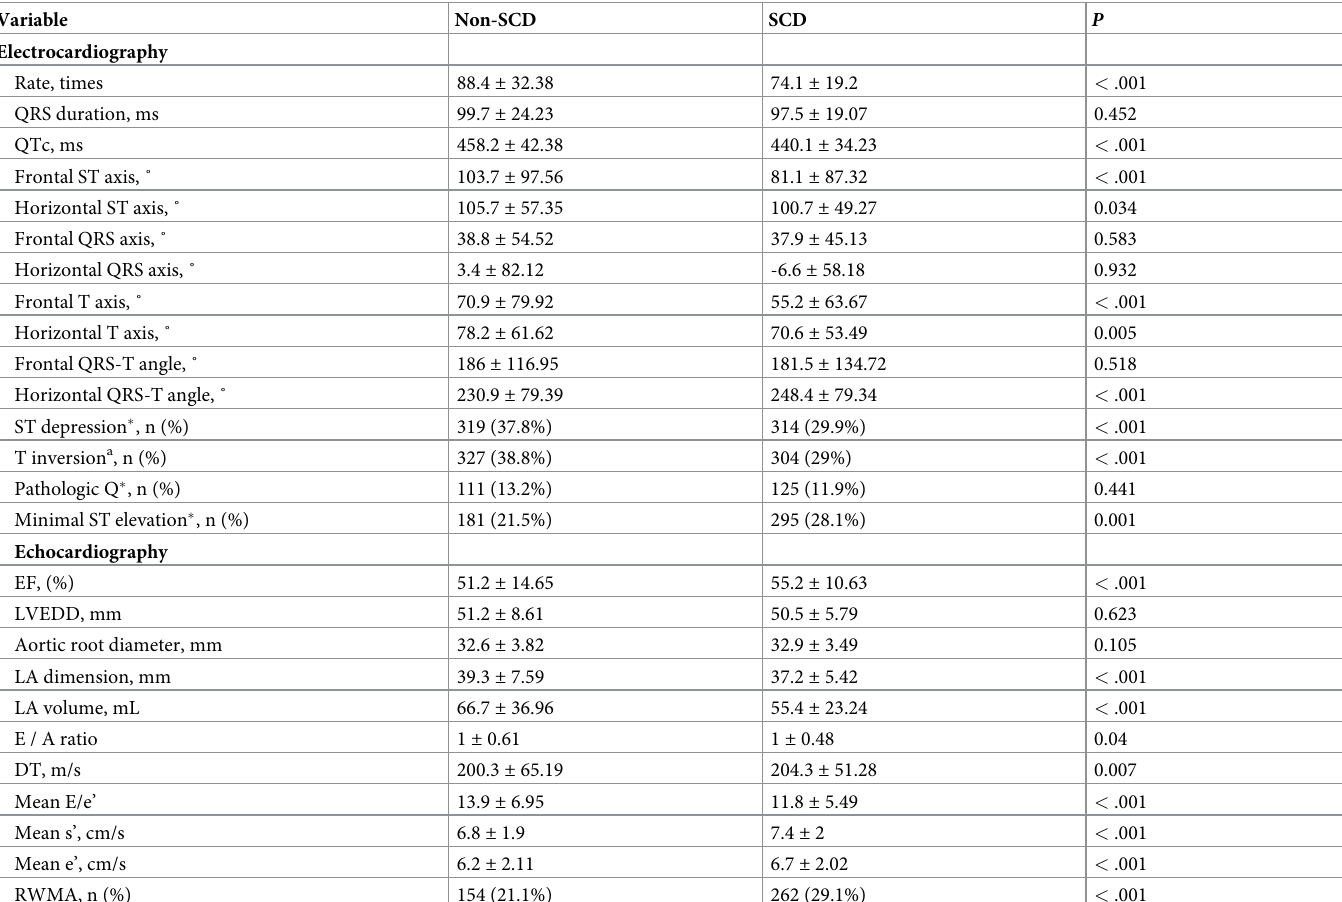
Table 3. Relation between coronary artery disorder and variables in electrocardiography and echocardiography.